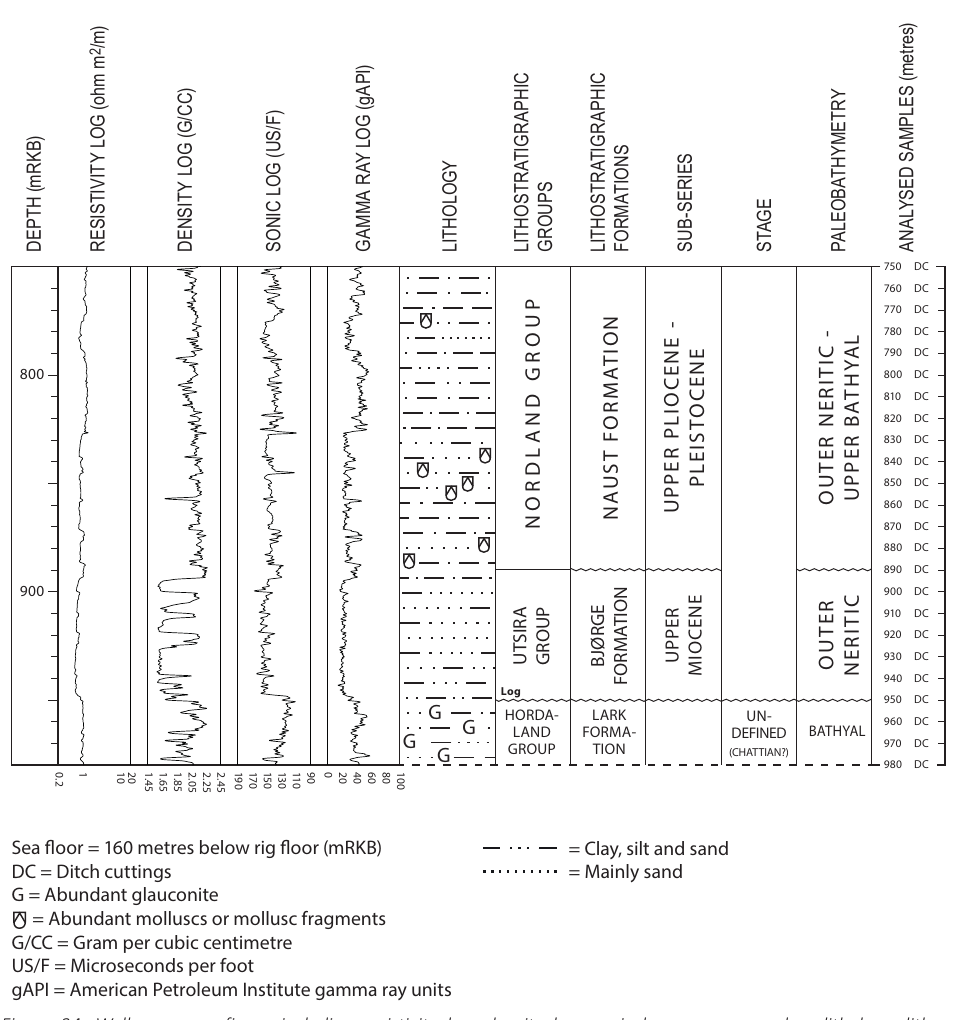
Figure 34. Well summary figure including resistivity log, density log, sonic log, gamma-ray log, lithology, litho- stratigraphic units, sub-series, stage, paleobathymetry and analysed samples for the upper part of the investigated sequence in well 34/10–17 (Chattian? to upper Pliocene–Pleistocene; modified after Eidvin et al., 2013d). Fig.